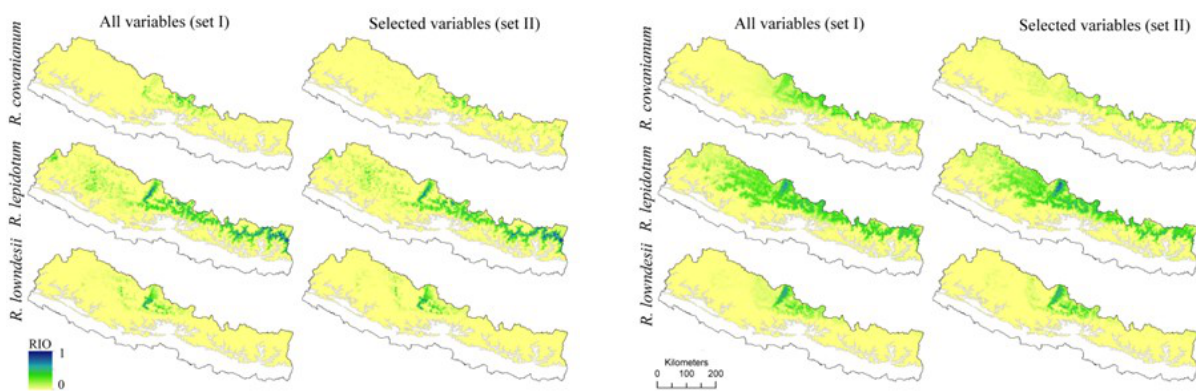
Figure 4. Maps depicting the values of the predicted relative index of occurrence (RIO) for current climate (left side panel, columns 1 and 2) and future climate (right side panel, columns 3 and 4). The predictions are for presence data with random pseudo - absences (RanPs). The white area inside the Nepal boundary is beyond the range of the study area.